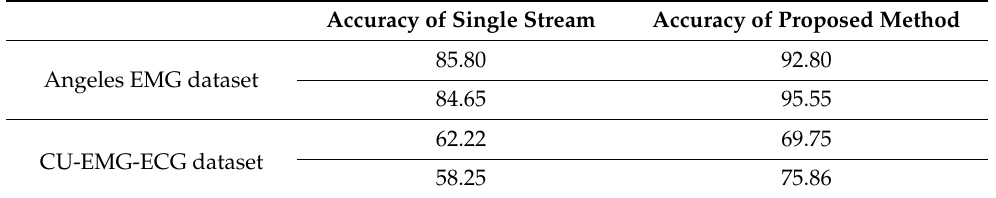
Table 6. Test accuracy samples for paired T test.